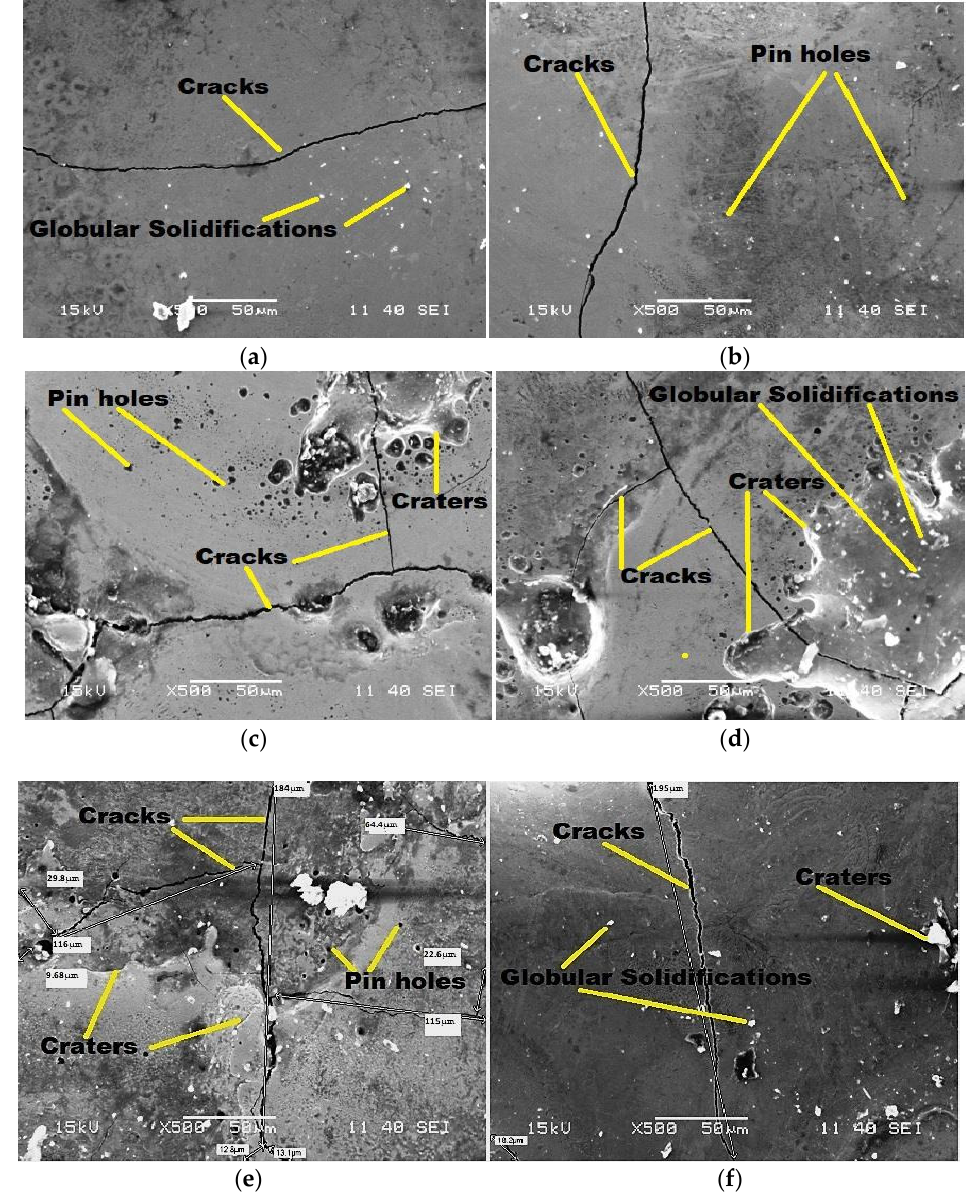
Figure 6. SEM micrograph of SS316 machined by Al, Brass and Cu electrode with 500× magnification. ( a ) Cu tool tip with I = 5 A, T on = 1000 µs, T off = 2000 µs. ( b ) Cu tool tip with I = 10 A, T on = 1000 µs, T off = 2000 µs. ( c ) Al tool tip with I = 5 A, T on = 1000 µs, T off = 2000 µs. ( d ) Al tool tip with I = 10 A, T on = 1000 µs, T off = 2000 µs. ( e ) Brass tool tip with I = 5 A, T on = 1000 µs, T off = 2000 µs. ( f ) Brass tool tip with I = 10 A, T on = 1000 µs, T off = 2000 µs.